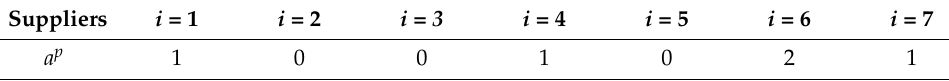
Table 3. Number of weeks allowed for late delivery.